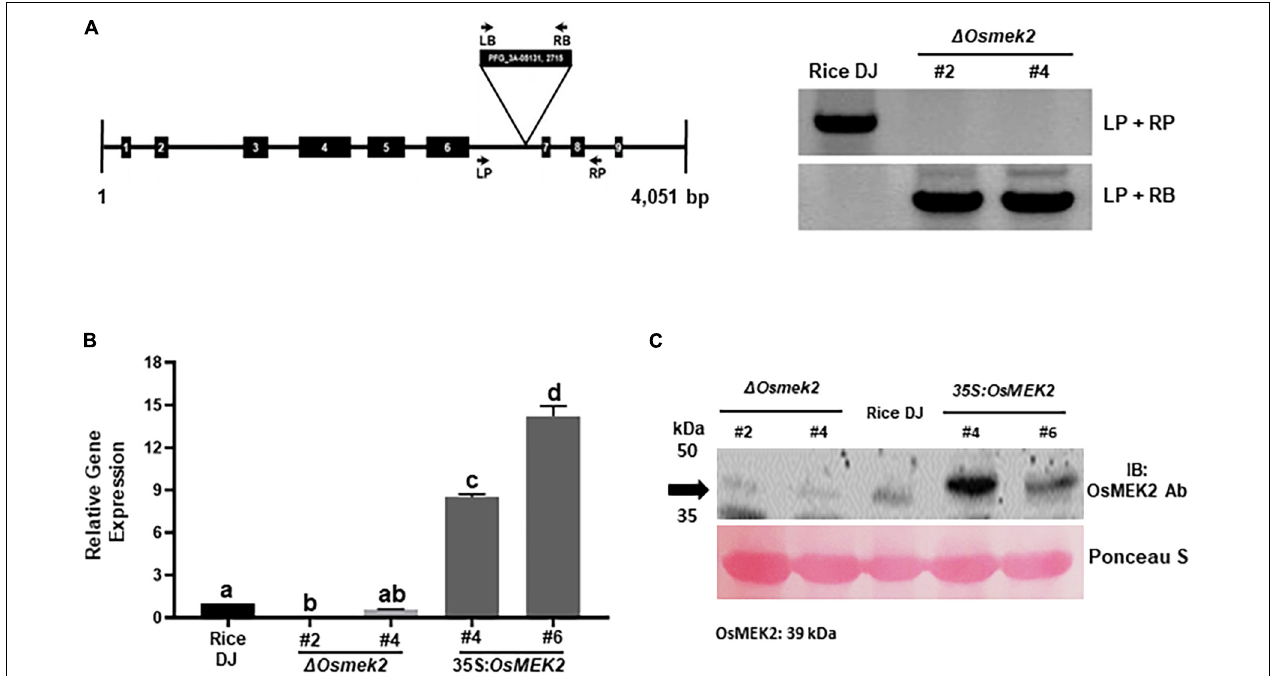
FIGURE 1 | Genotyping, transcriptional, and immunoblotting analyses of (cid:49) Osmek2 knock-out and 35S: OsMEK2 overexpression lines. (A) Genotyping of (cid:49) Osmek2 plants. The schematic diagram shows the T-DNA insertion site in the OsMEK2 gene. Exons and introns are depicted by solid boxes and lines, respectively. The T-DNA insertion (cid:49) Osmek2 knock-out plants (M5) were detected using the gene primers (LP + RP) and the vector primers (LP + RB). LP, left primer; RP, right primer; LB, left border; RB, right border. (B) Transcriptional analysis of OsMEK2 expression in wild-type (WT) rice (cultivar DJ), (cid:49) Osmek2 #2 and #4, and 35S: OsMEK2 #4 and #6 plants using quantitative real-time RT-PCR. (C) SDS-PAGE and immunoblotting assays of OsMEK2 expression in wild-type (WT) rice (cultivar DJ), (cid:49) Osmek2 #2 and #4 and 35S: OsMEK2 #4 and #6 plants using OsMEK2 Ab (EnoGene R (cid:13) E580135-A-SE) ( ∼ 39 kDa). Ab, antibody; IB, immunoblot; PAGE, polyacrylamide gel electrophoresis.